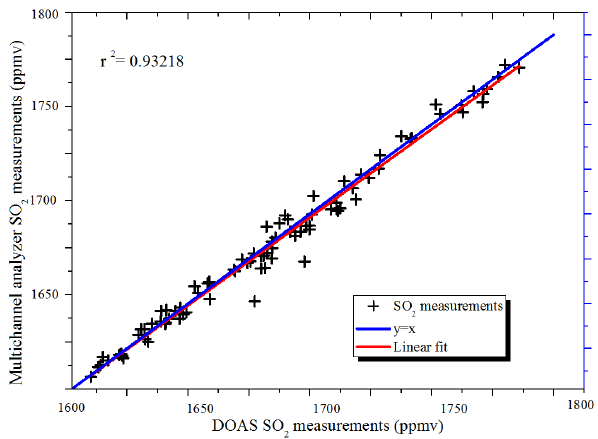
Figure 16. Correlation between the DOAS analyzer and the multi- channel analyzer for the time series shown in Fig. 15 after outliers were removed. The green box represents SO 2 concentrations that appeared with the highest